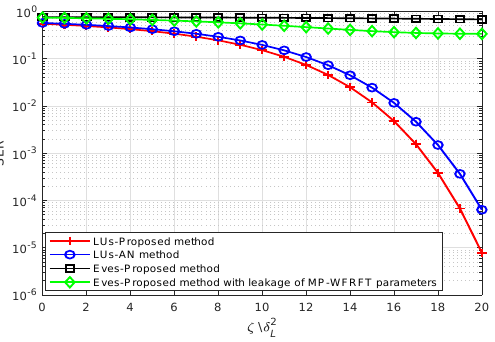
Figure 8. The SER performance of cooperative LUs versus the desired received power to noise